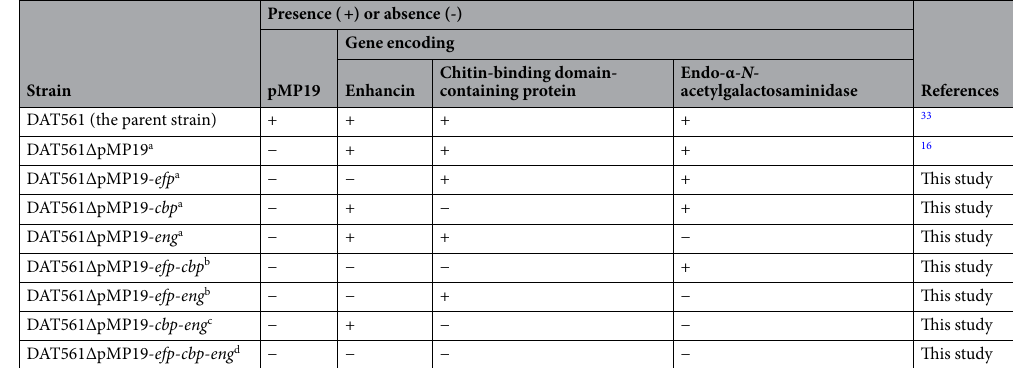
Table 2. M. plutonius strains used in this study. a Strains derived from DAT561. b Strains derived